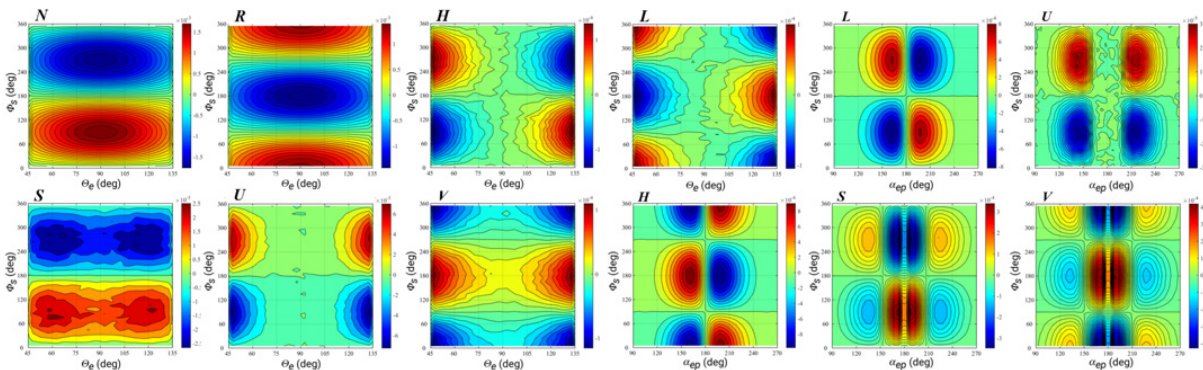
Figure 2. Sensitivity maps for the N , R , H , L , S , U and V coefficient as a function of the polar electron angle θ e or the relative electron-proton angle α ep and the azimuthal spin projection angle φ s (arbitrary units). The kinematical acceptance is defined by